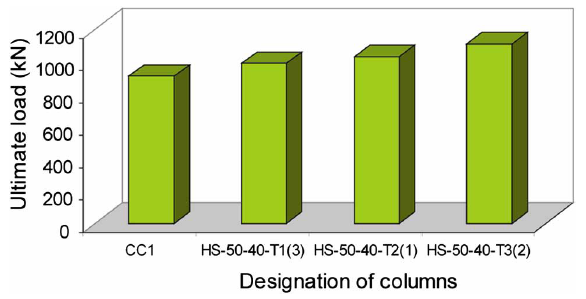
Fig. 18. Ultimate load for columns HS-50-40 (cid:1) comparison